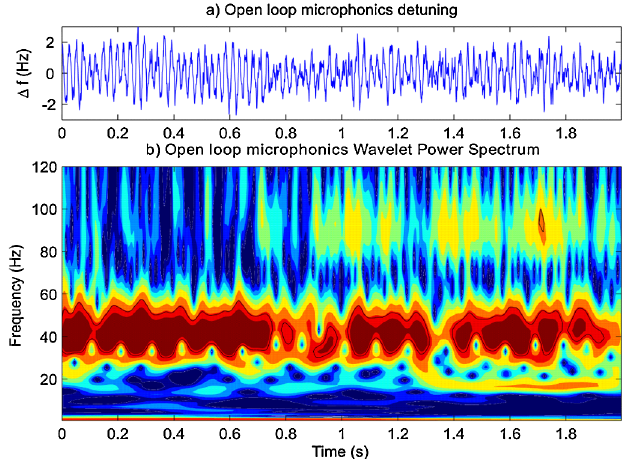
.FIG. 7. (Color) Open loop microphonics detuning measurement at Q L ¼ 2 : 7 (cid:6) 10 7 in the time domain (upper plot). The lower plot is the time-frequency map obtained by a wavelet analysis of the data with Morlet wavelets scaling the frequencies from 0.45– 486 Hz. The color code represents the detuning spectral power content. Strong changes of the detuning amplitude for the first excited mechanical eigenmode are between 0–10 Hz on a 100 ms time